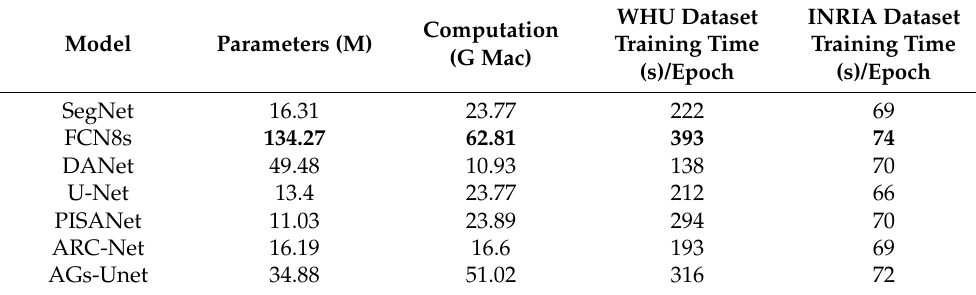
Table 5. Parameters, computation, and training time of each model in WHU dataset and INRIA dataset. The highest scores are highlighted in